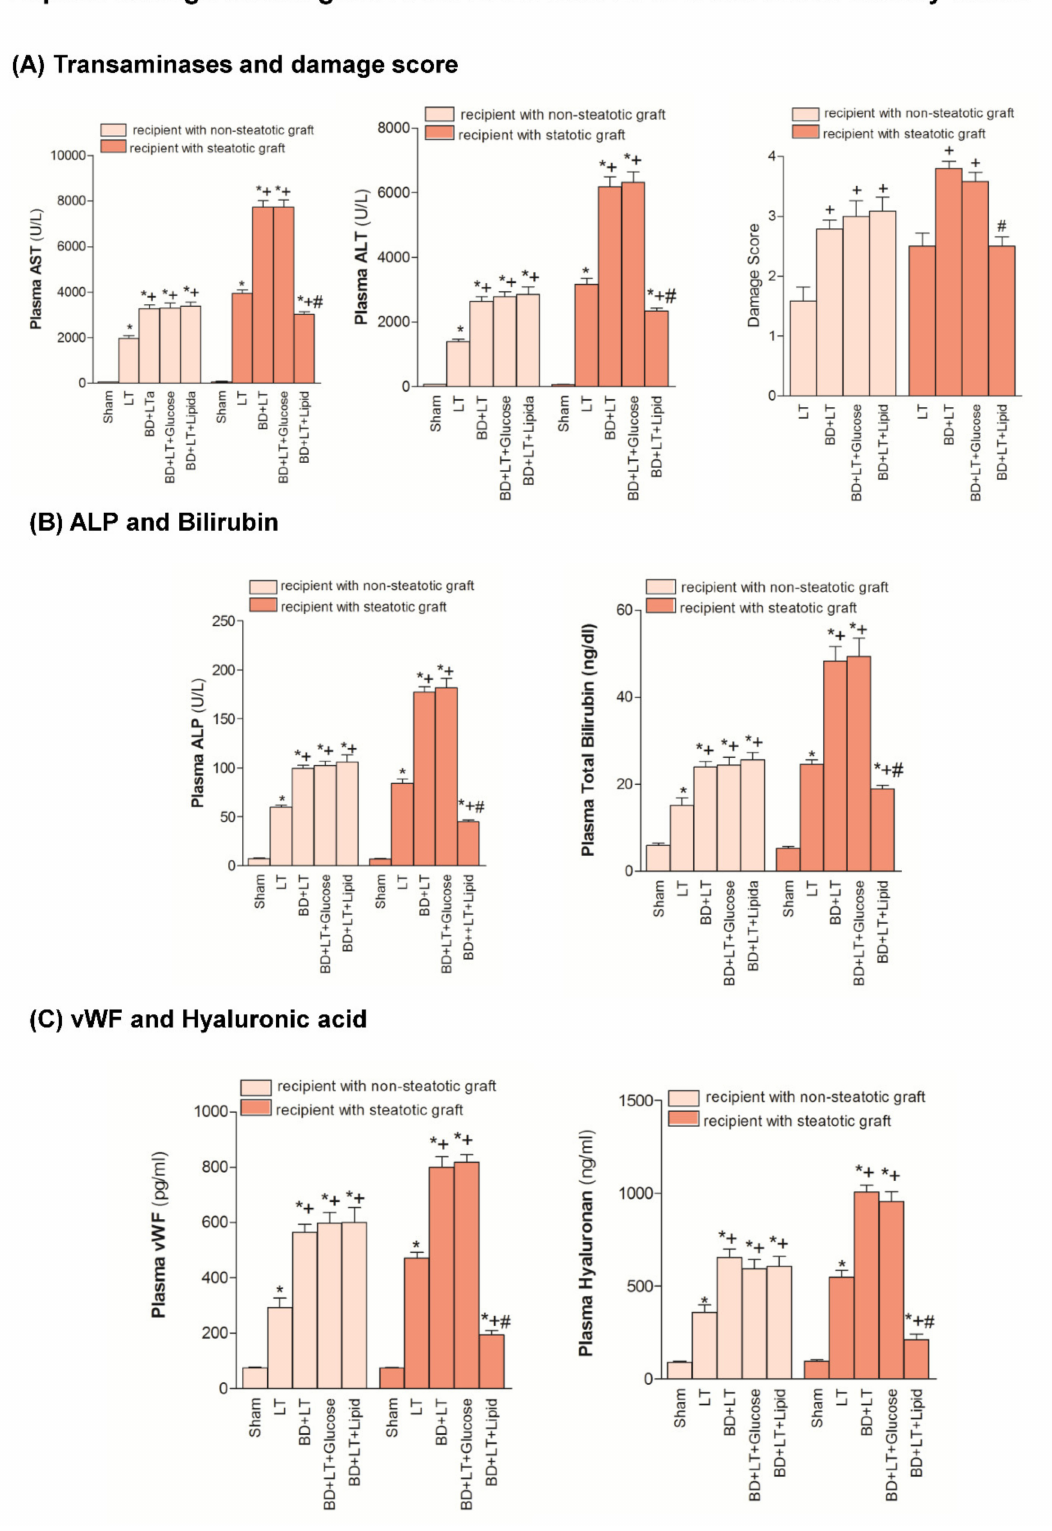
Figure 5. Effects of glucose and lipids on hepatic damage in steatotic and non-steatotic LT in a nutritional obesity model. ( A ) AST and ALT in plasma, and damage score in liver. ( B ) Alkaline phosphatase (ALP) and bilirubin in plasma. ( C ) von Willebrand factor (vWF) and hyaluronic acid in plasma. * p < 0.05 vs. Sham. + p < 0.05 vs. Liver Transplantation (LT). # p < 0.05 vs. Brain Death+Liver Transplantation (BD + LT). DBD, Donors after Brain